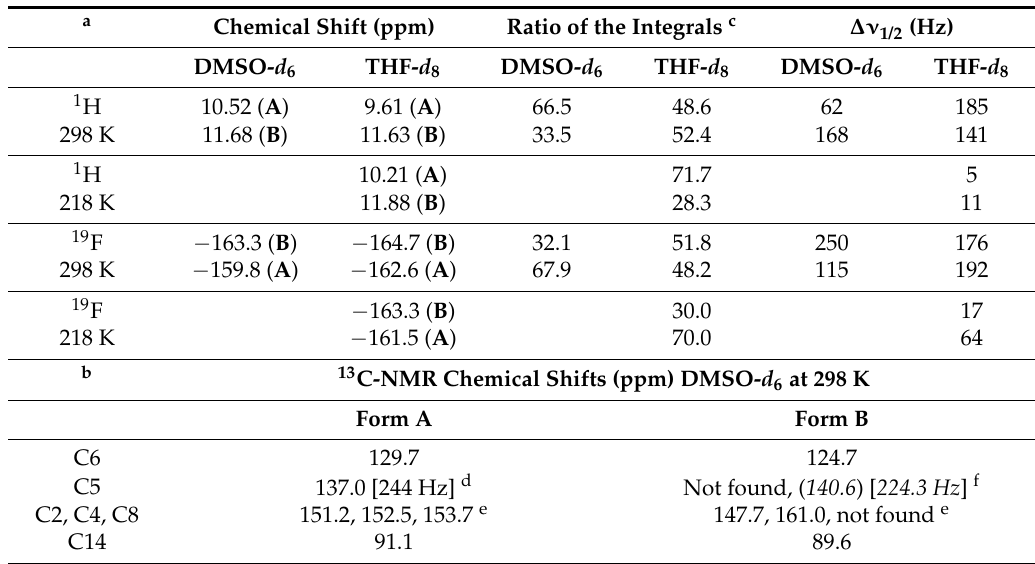
Table 1. The 1 H/ 19 F, 13 C-NMR chemical shifts, 1 H/ 19 F ∆ ν 1/2 and integrals (of the down-field